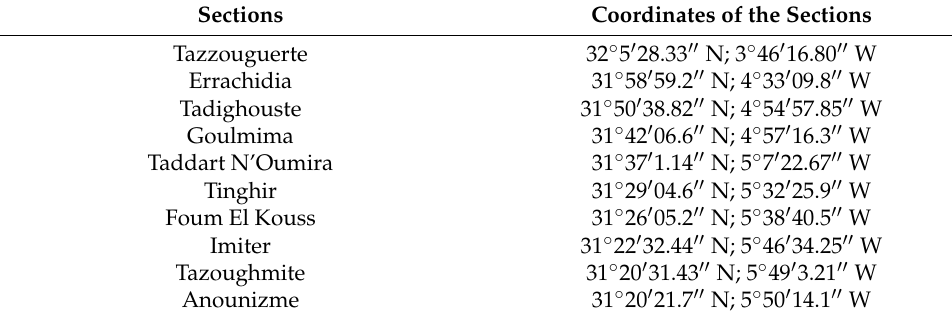
Table 1. Geographical coordinates of the